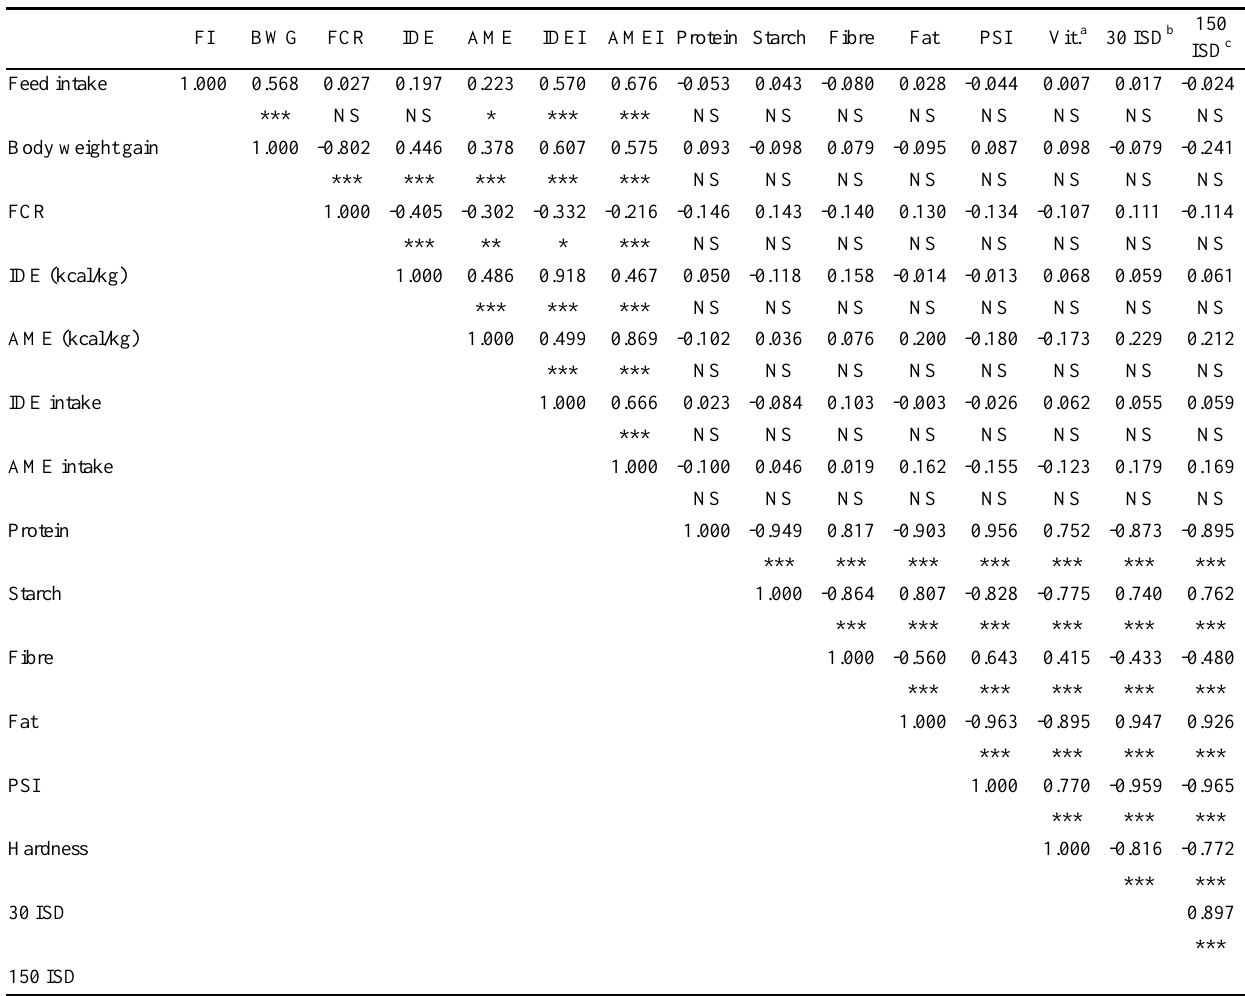
Table 7. Correlation matrix showing correlation coefficient (r) and significance for the relationship between all parameters